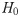
(A) The SNP and the phenotype are independent under the null hypothesis (H0) and correlated under the alternative hypothesis (H1). (B) In the case of population structure, the structure will influence many SNPs and the phenotype. In this case, correlation between SNPs and the phenotype will be induced in both the null and alternate hypothesis. SNP, single nucleotide polymorphism.